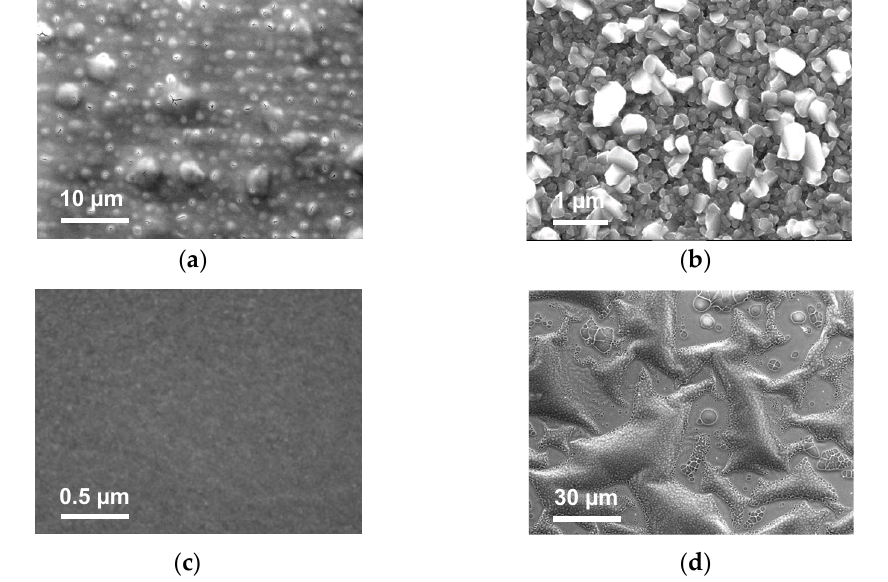
Figure 9. Top-view SEM micrographs of reference films after air annealing at 950 °C: ZrN ( a ); CrN ( b ); AlN ( c ); and Si 3 N 4 ( d ). Note the different scale bar for the different images.